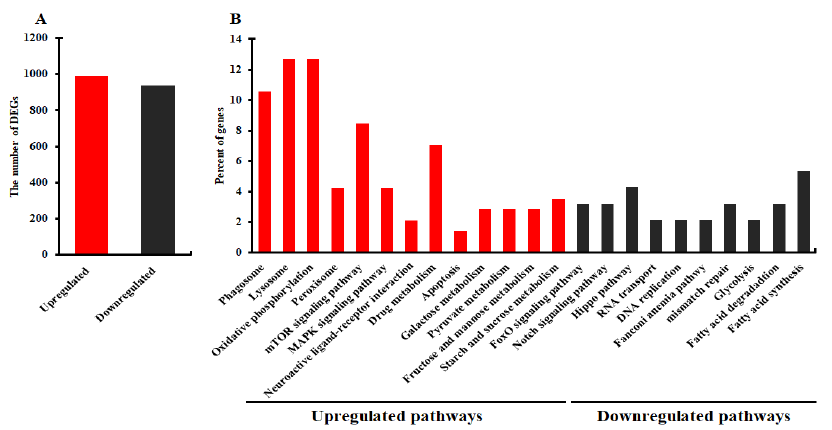
Figure 10. Transcriptome analysis following knockdown of ApSOCS-2 in A. pernyi . ( A ): the number of DEGs in dsApSOCS-2 and M. luteus treated larvae compared to dsGFP and M. luteus challenged group. ( B ): KEGG pathway enrichment analysis of differentially expressed genes in the transcriptome following dsApSOCS-2 and M. luteus in A. pernyi .